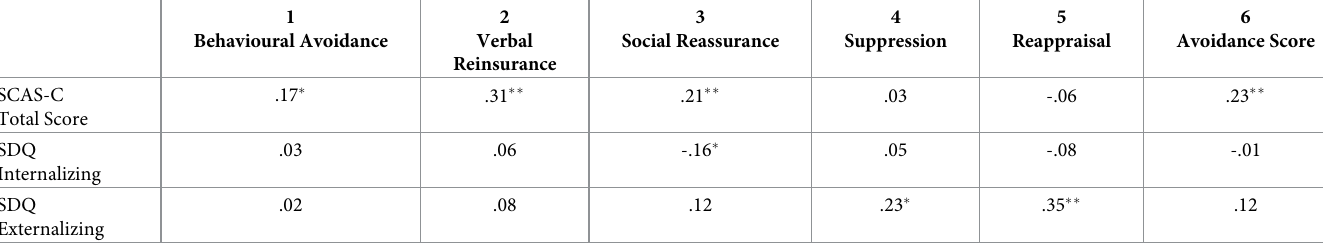
SCAS-C: Spence Children Anxiety Scale, SDQ: Strength and Difficulties Questionnaire